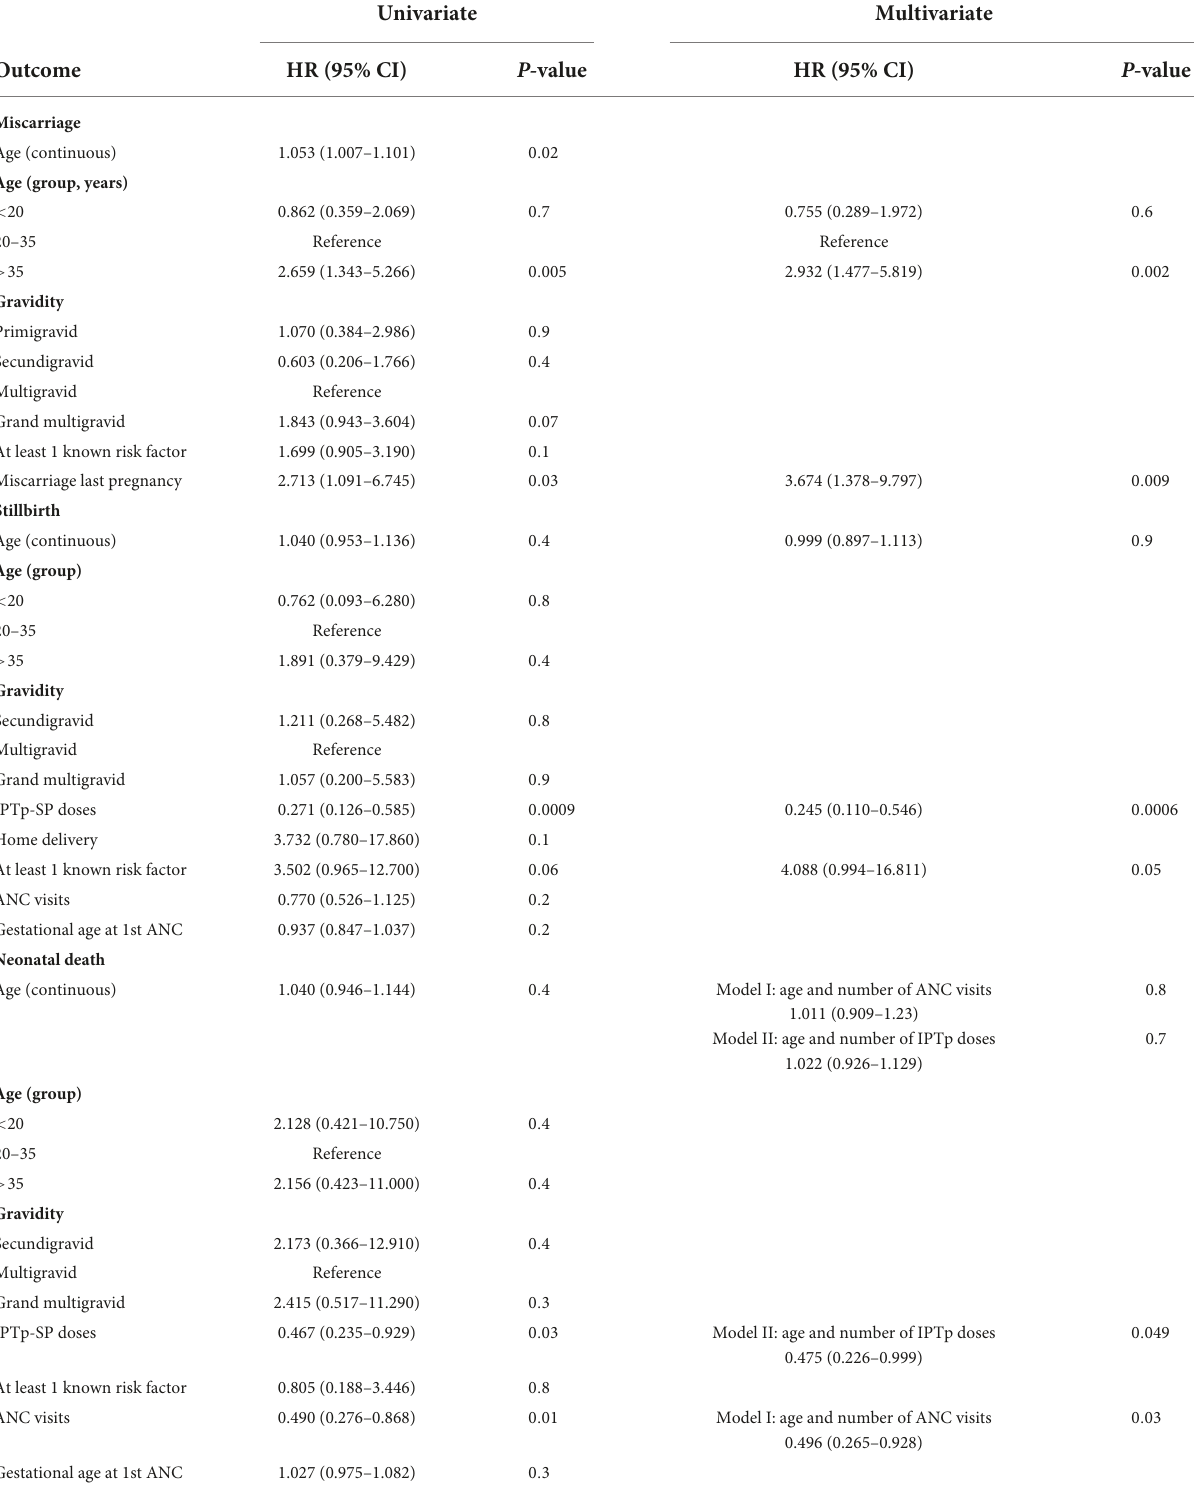
TABLE 4 Risks associated with fetal and neonatal